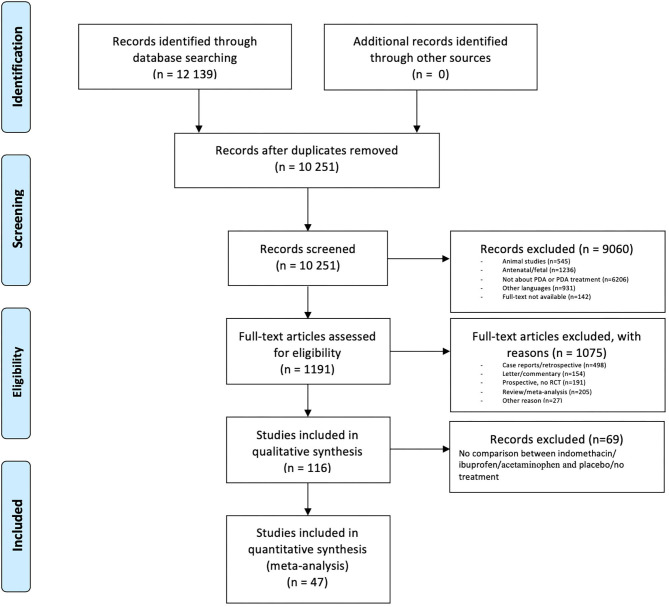
PRISMA flow diagram.